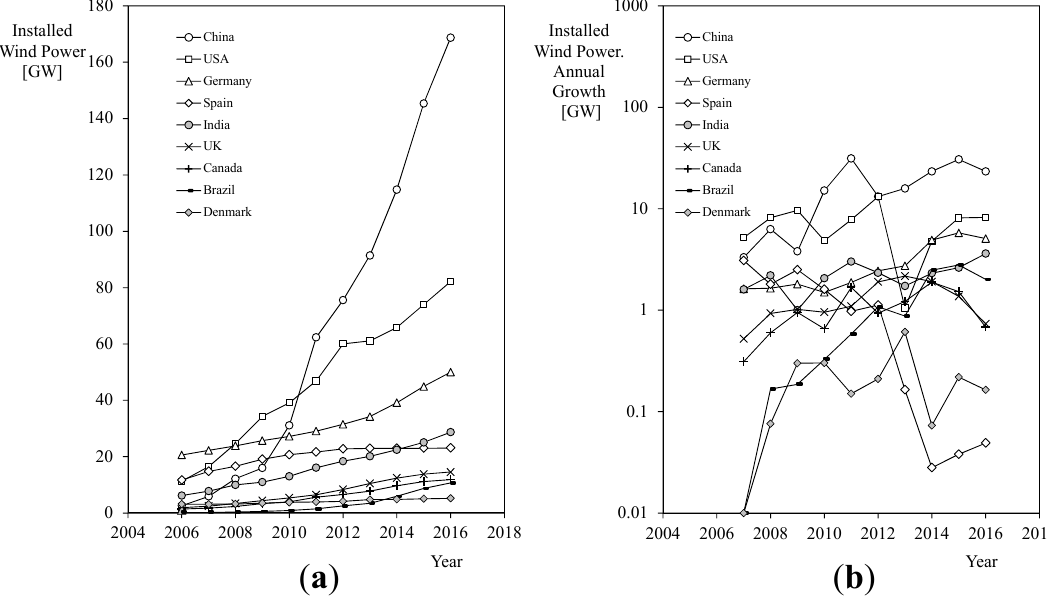
Figure 2. Installed wind power in some of the most relevant countries ( a ) and its annual growth ( b ). Source: Global Wind Energy Council.